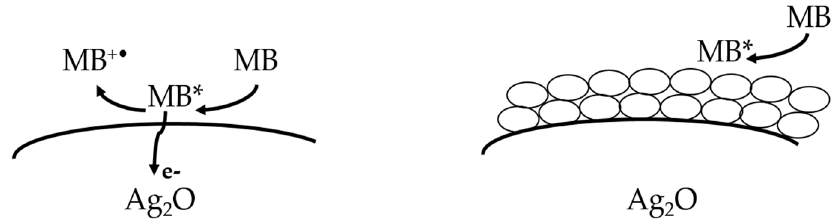
Figure 7. Possible mechanism of MB bleaching by Ag 2 O and Ag 2 O-containing mixtures and under visible light composites under visible light illumination.